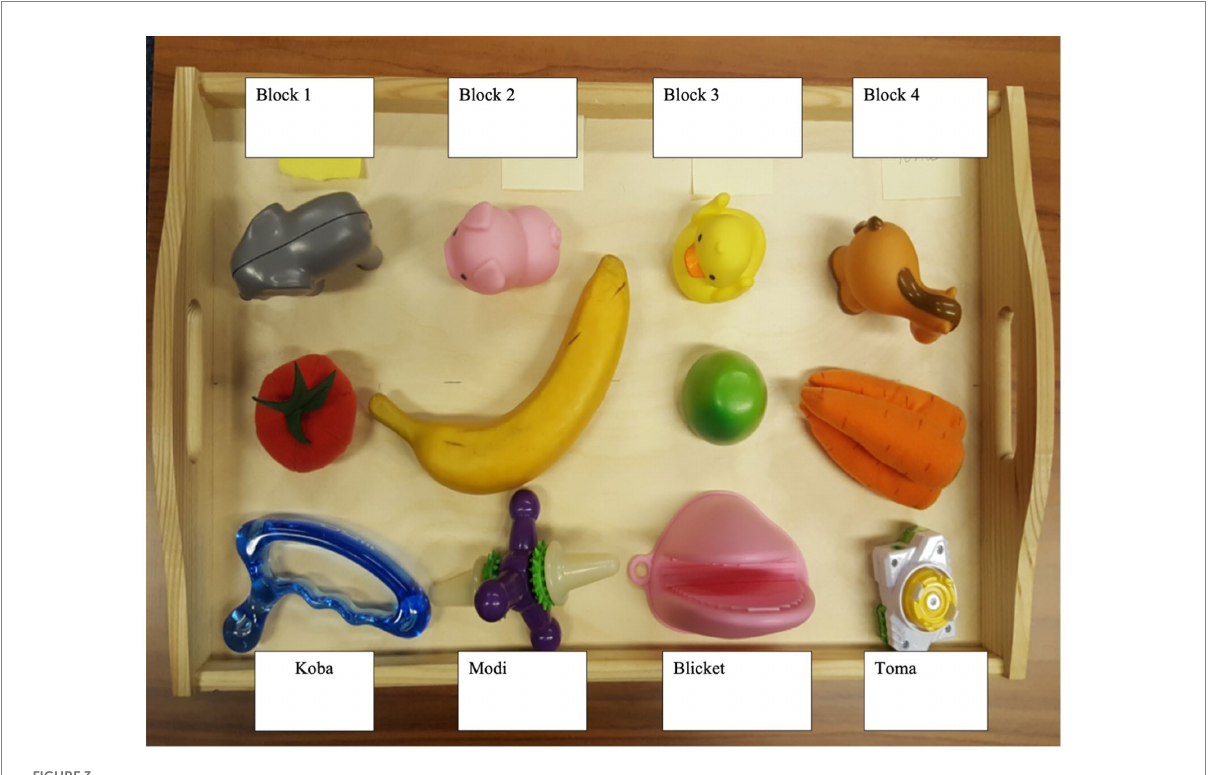
FIGURE 3 Learning phase: Novel label learning task